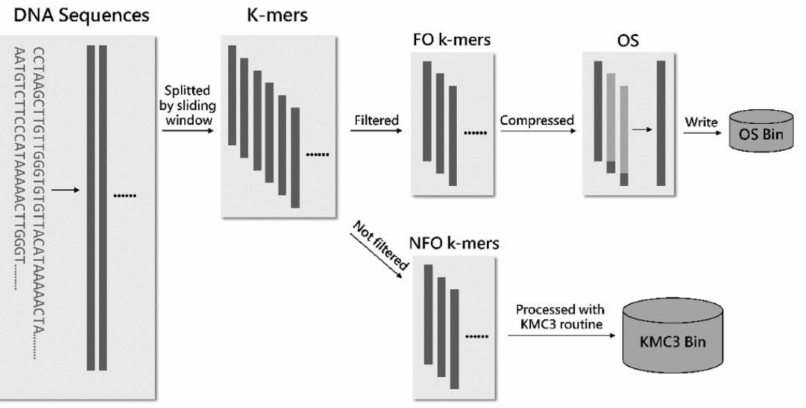
Figure 9. The partition procedure of the revised KMC3 algorithm. FO k-mers denote first-occurring k-mers, NFO k-mers denote non-first-occurrence k-mers, and OS denotes overlapping sequence.